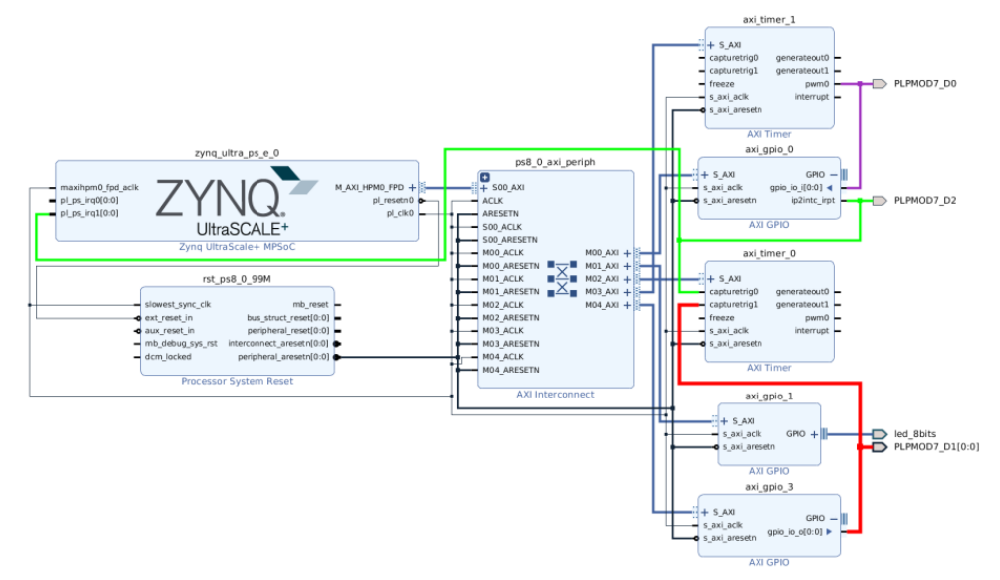
Figure 1. Block diagram designed in Vivado. The AXI interconnect is shared among all processors, which means that it can be accessed both by the hypervisor and the standalone application. A timer is in charge of generating periodic interrupts while another interrupt measures the